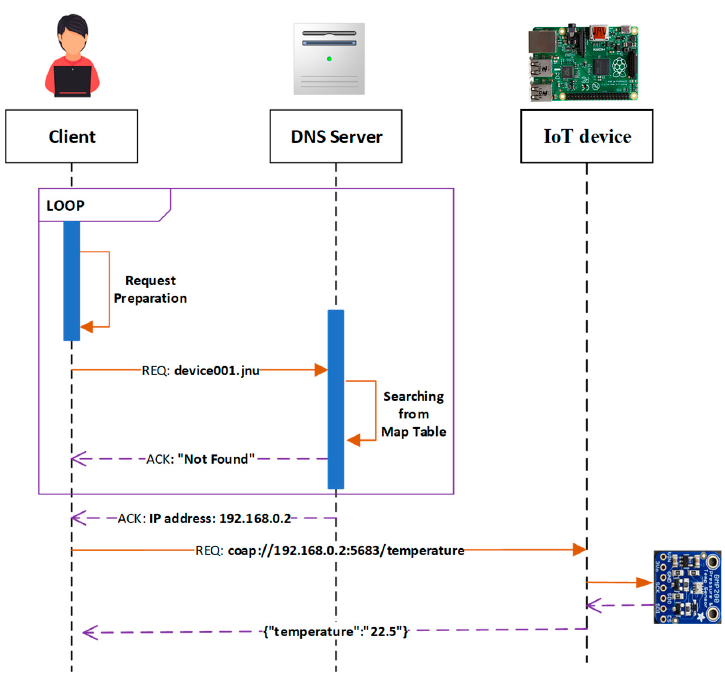
Figure 8. Sequence diagram of the device discovery and sensing data.